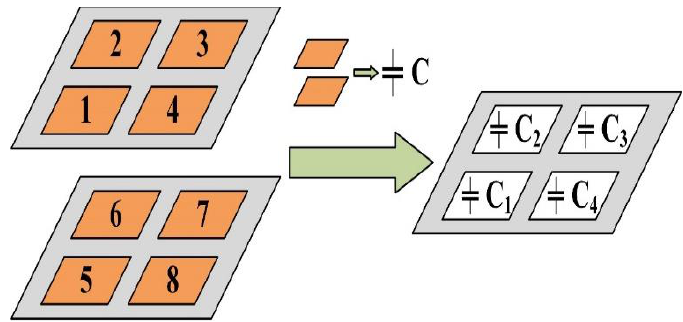
Figure 2. Schematic diagram of the four parallel plate capacitors.